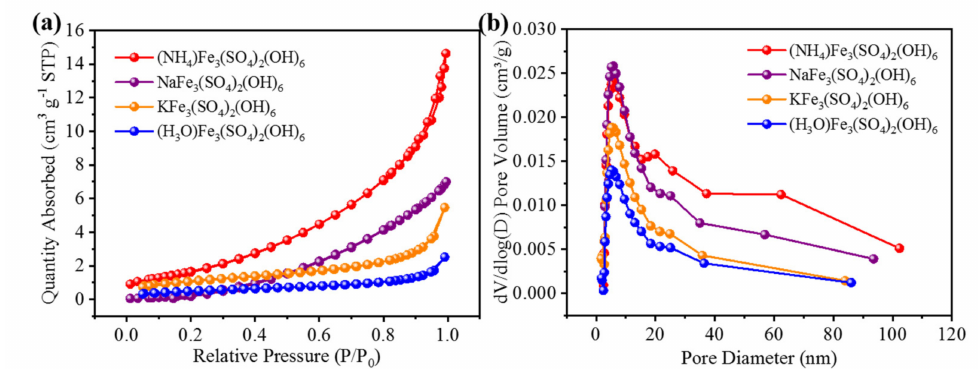
Figure 2. ( a ) N 2 adsorption-desorption isotherm curves, ( b ) the corresponding pore size distribution